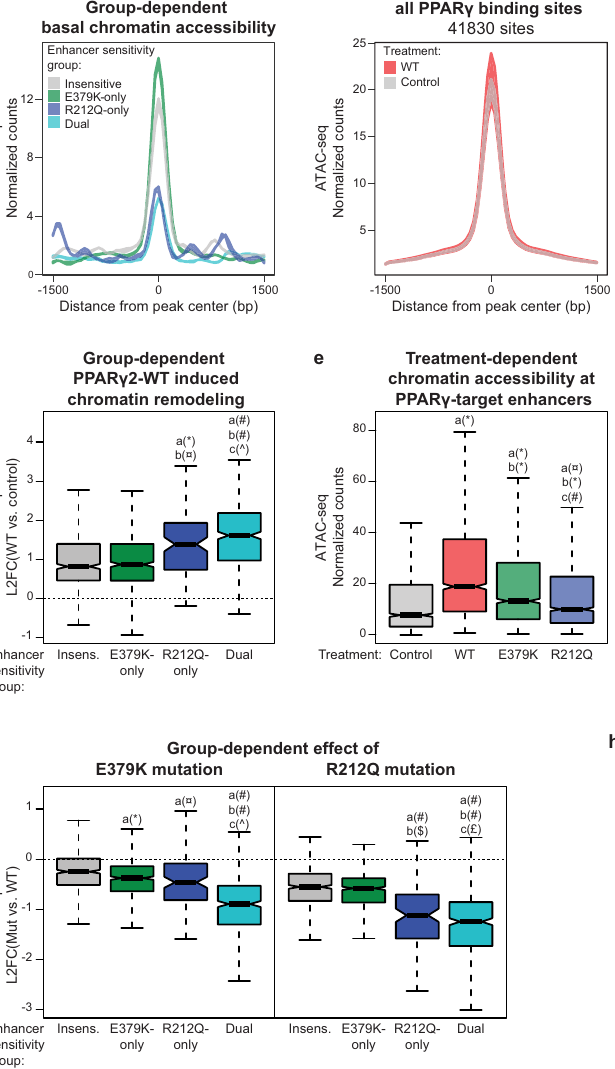
pairwise Wilcoxon rank sum tests with Benjamini – Hochberg correction, a, versus control; b, versus WT expression; c, versus E379K-expression, * p <2e-16, ¤ p =2.3e- 9, # p =6.8e-9. f ATAC-seq signal of E379K (left) and R212Q (right) treated cells relative to the WT ATAC-seq signal at enhancers where PPAR γ 2-WT signi fi cantly induces remodeling(94sitesde fi nedinpanel c ). Linearmodels fi tting thedataare indicatedwithdashedlines.Enhancersthatsigni fi cantlyloseATAC-seqsignalupon R212Q mutation are marked with dark blue (DESeq2 with Benjamini – Hochberg correction, two-sided test, padj <0.05, L2FC(R212Q vs. WT)<0). Selected enhan- cers are indicated. g Mutation-induced changes in remodeling capacity within enhancer groups. Signi fi cance wasassessed asin panel d . * p =1.2e-6, ¤ p =0.00027, # p <2e-16, ^ p =1.9e-11, $ p =8e-16, £ p =0.043. h Enhancer group-dependend PPAR γ - inducedgaininC/EBP α ChIP-seqsignaluponPPAR γ 2andC/EBP α co-expressionin PPAR γ − / − MEF-CAR cells. Data from Madsen et al. 6 . Signi fi cance was assessed as in panel d . * p =2.2e-6, ¤ p =1.7e-6, # p =0.0014. Data in boxplots are presented as notch, median; box, fi rst and third quartiles; whiskers, 1.5 times the interquartile range. Source data are provided in the Source Data fi